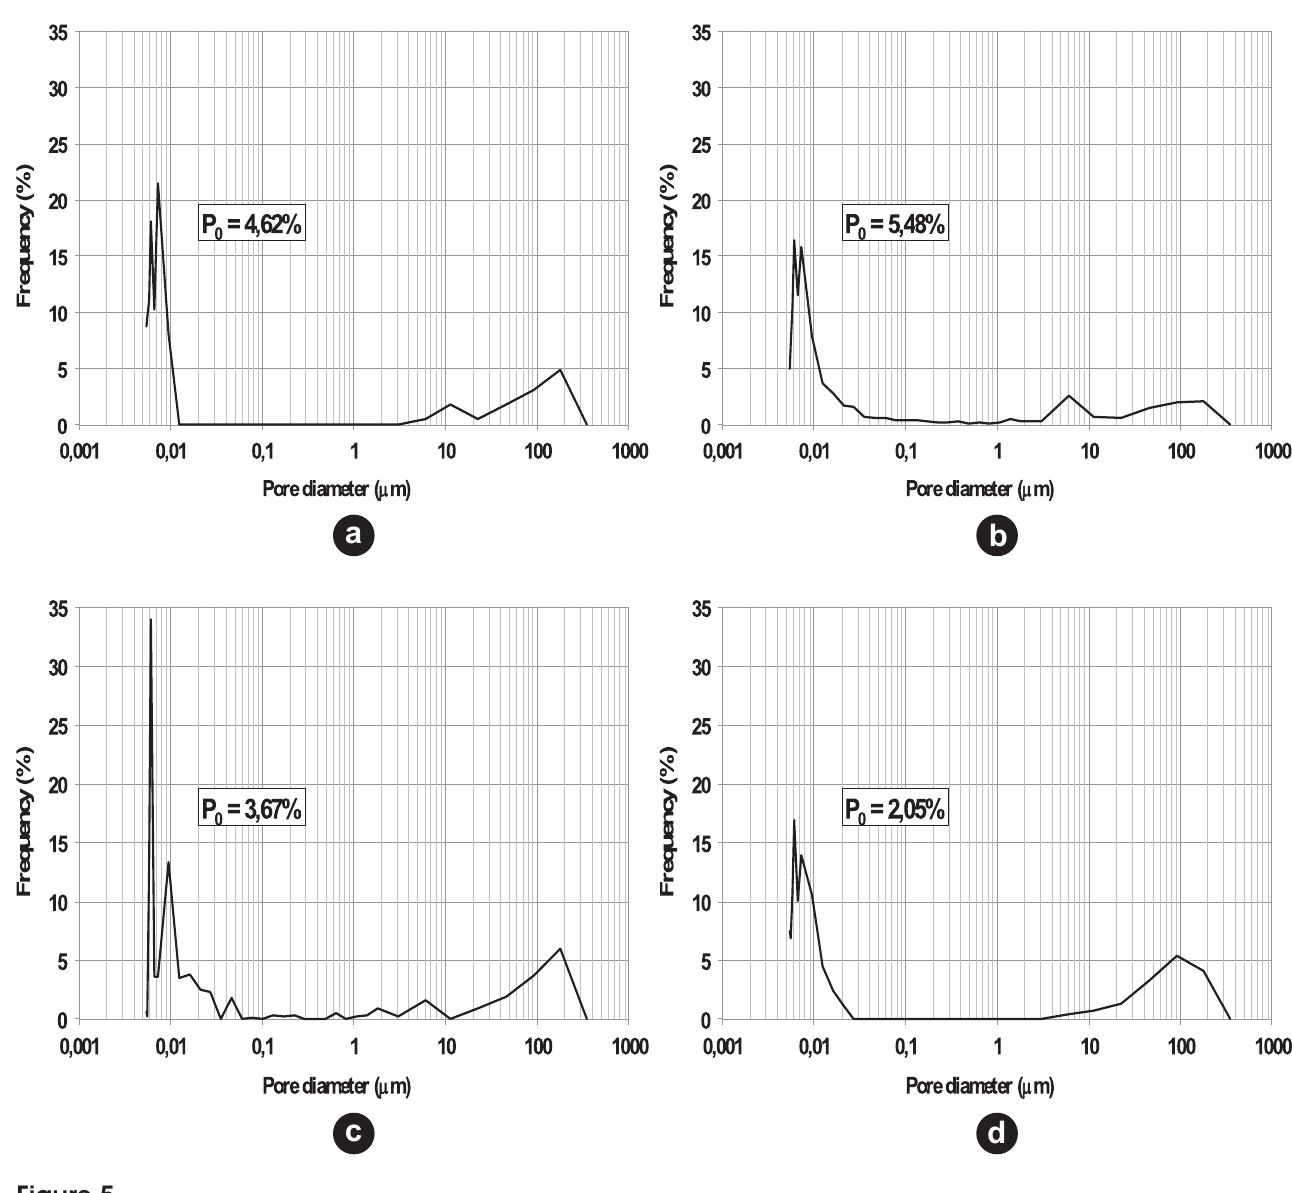
Pore size distribution and Porosity (P0) of mixtures (a) 11 nS; (b) 6 nS; (c) 3 nS; (d) 1.7